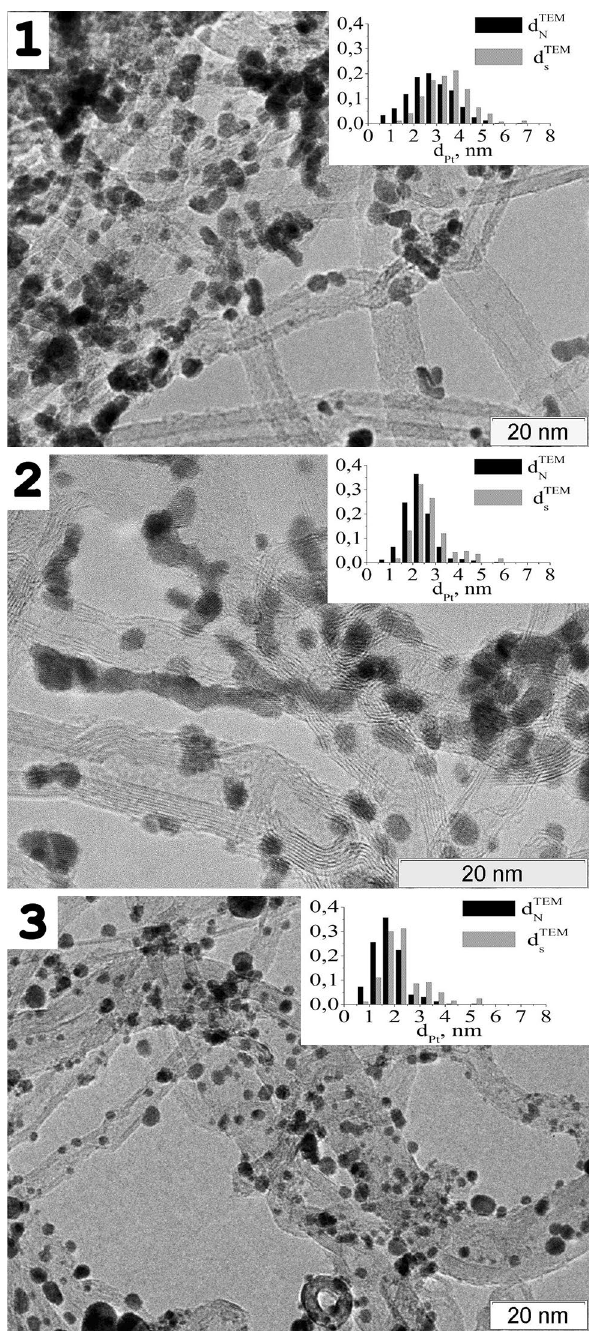
Fig. 3 TEM micrographs of the catalysts: Pt/CNT (1), Pt/CNT-M (2) and Pt/CNT-MF (3). Insets: Pt particle size distribution average size ( d NTEM , black) and surface average size ( d STEM ,